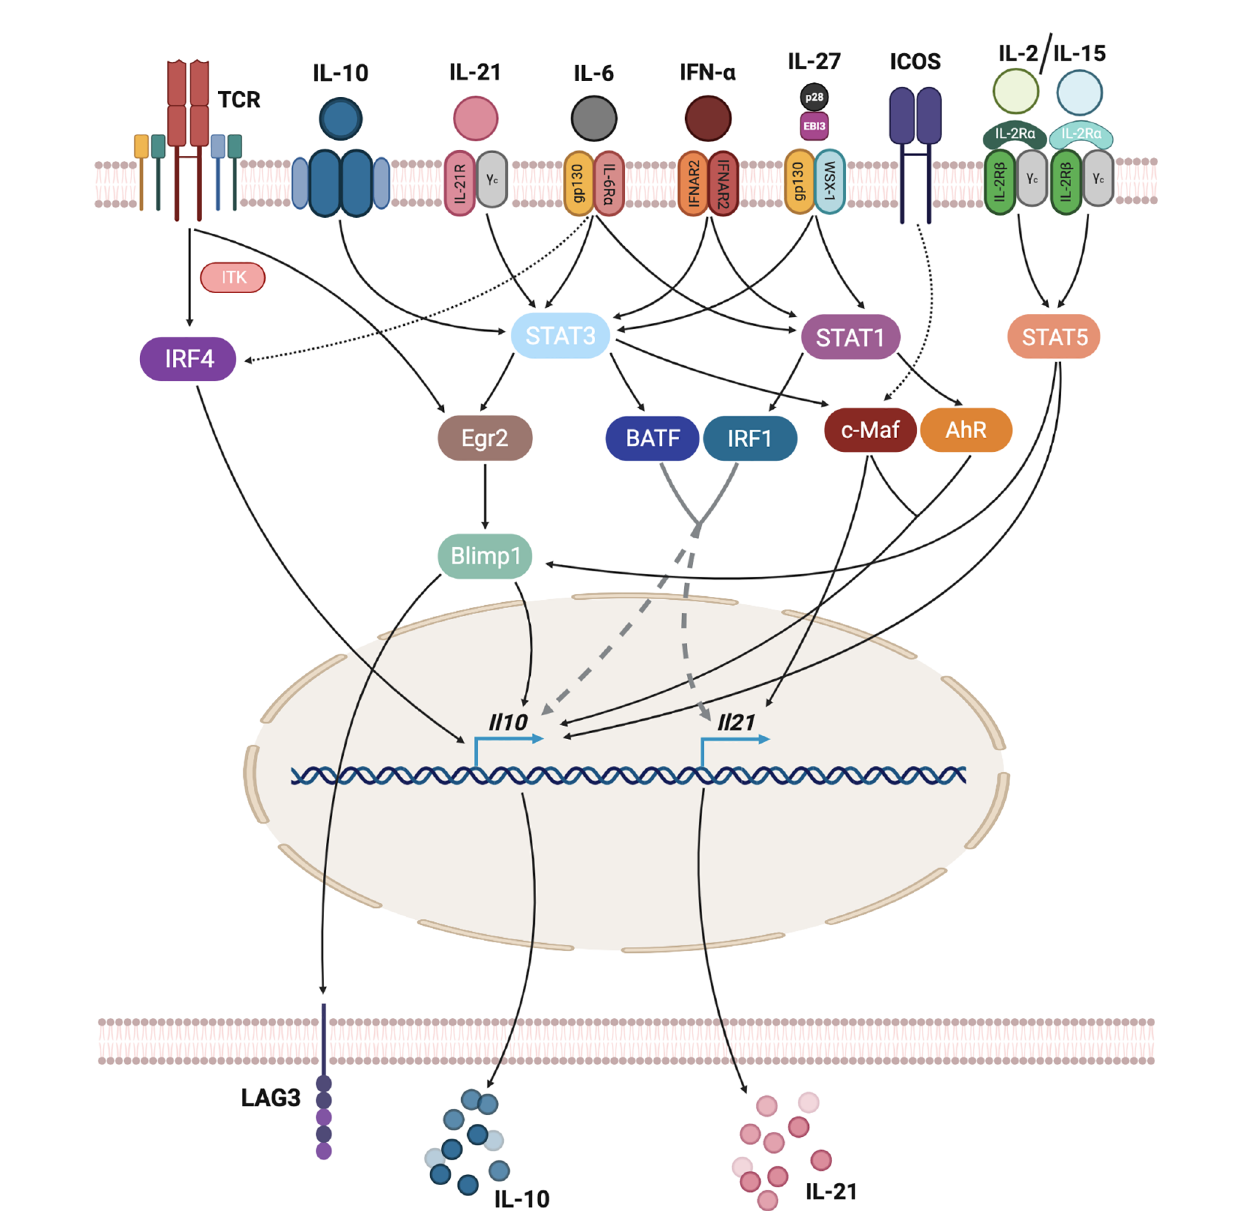
FIGURE 3 | Transcriptional regulation of TR1-like cell formation. TR1-like cell differentiation requires the integration of different stimuli. TCR signaling, through IRF4, can activate IL-10 expression. Many cytokines, including IL-10, IL-21, IL-6, type-I interferons and IL-27 signal via STAT1 and/or STAT3 proteins, activating several transcription factors that regulate IL-10 and IL-21 expression. ICOS signaling is also a direct regulator of IL-21 expression, while IL-2 or IL-15 cytokines can induce IL-10 directly via STAT5 binding to Il10 or via STAT5-mediated activation of